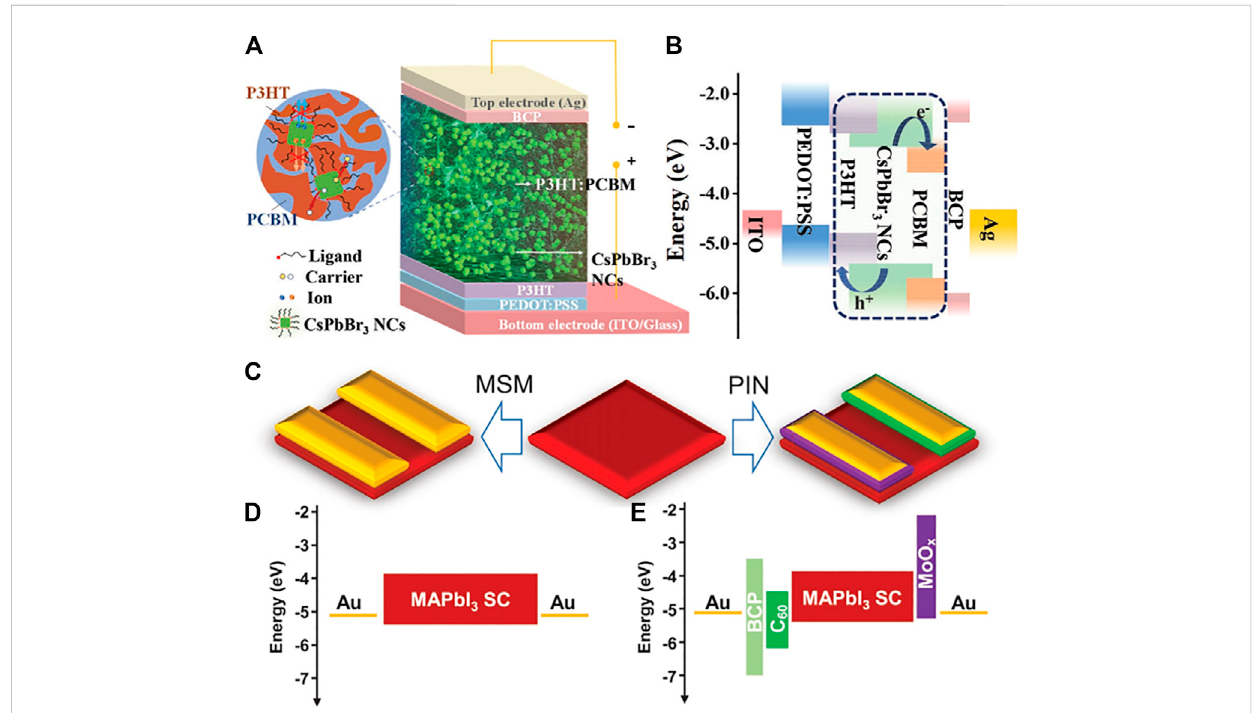
FIGURE 3 (A) Schematic diagram and (B) energy level of detector based on P3HT/PNCs/PCBM heterostructure. (C) Device structures of MSM and p-i-n; Energy level diagram of (D) MSM and (E) p-i-n device; Reproduced with permission from Ref. [34] (A,B, C) , Ref. [36] (D, E)